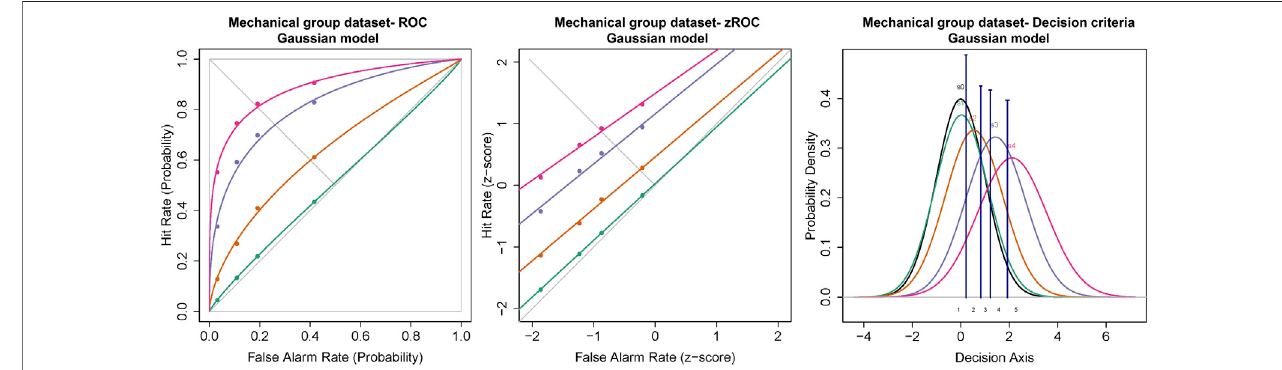
FIGURE 8 | ROC, zROC, and Gaussian distribution for the mechanical stimuli. The green line represents the sub-threshold stimuli followed by orange (threshold), purple (1.5x threshold), and pink (2x threshold). The black line (S 0 ) in density functions represent the noise distribution.